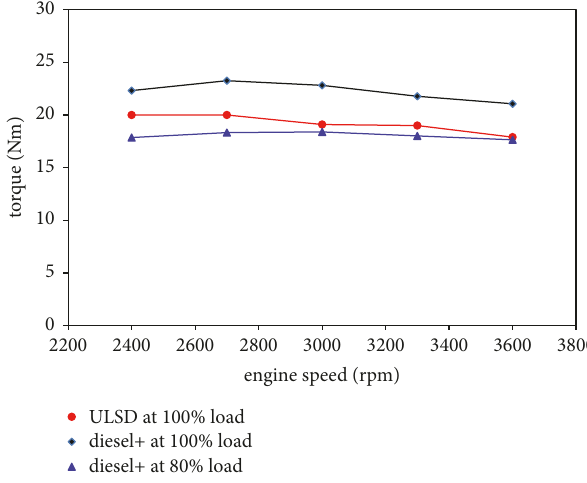
Figure 2: Engine torque variation with engine